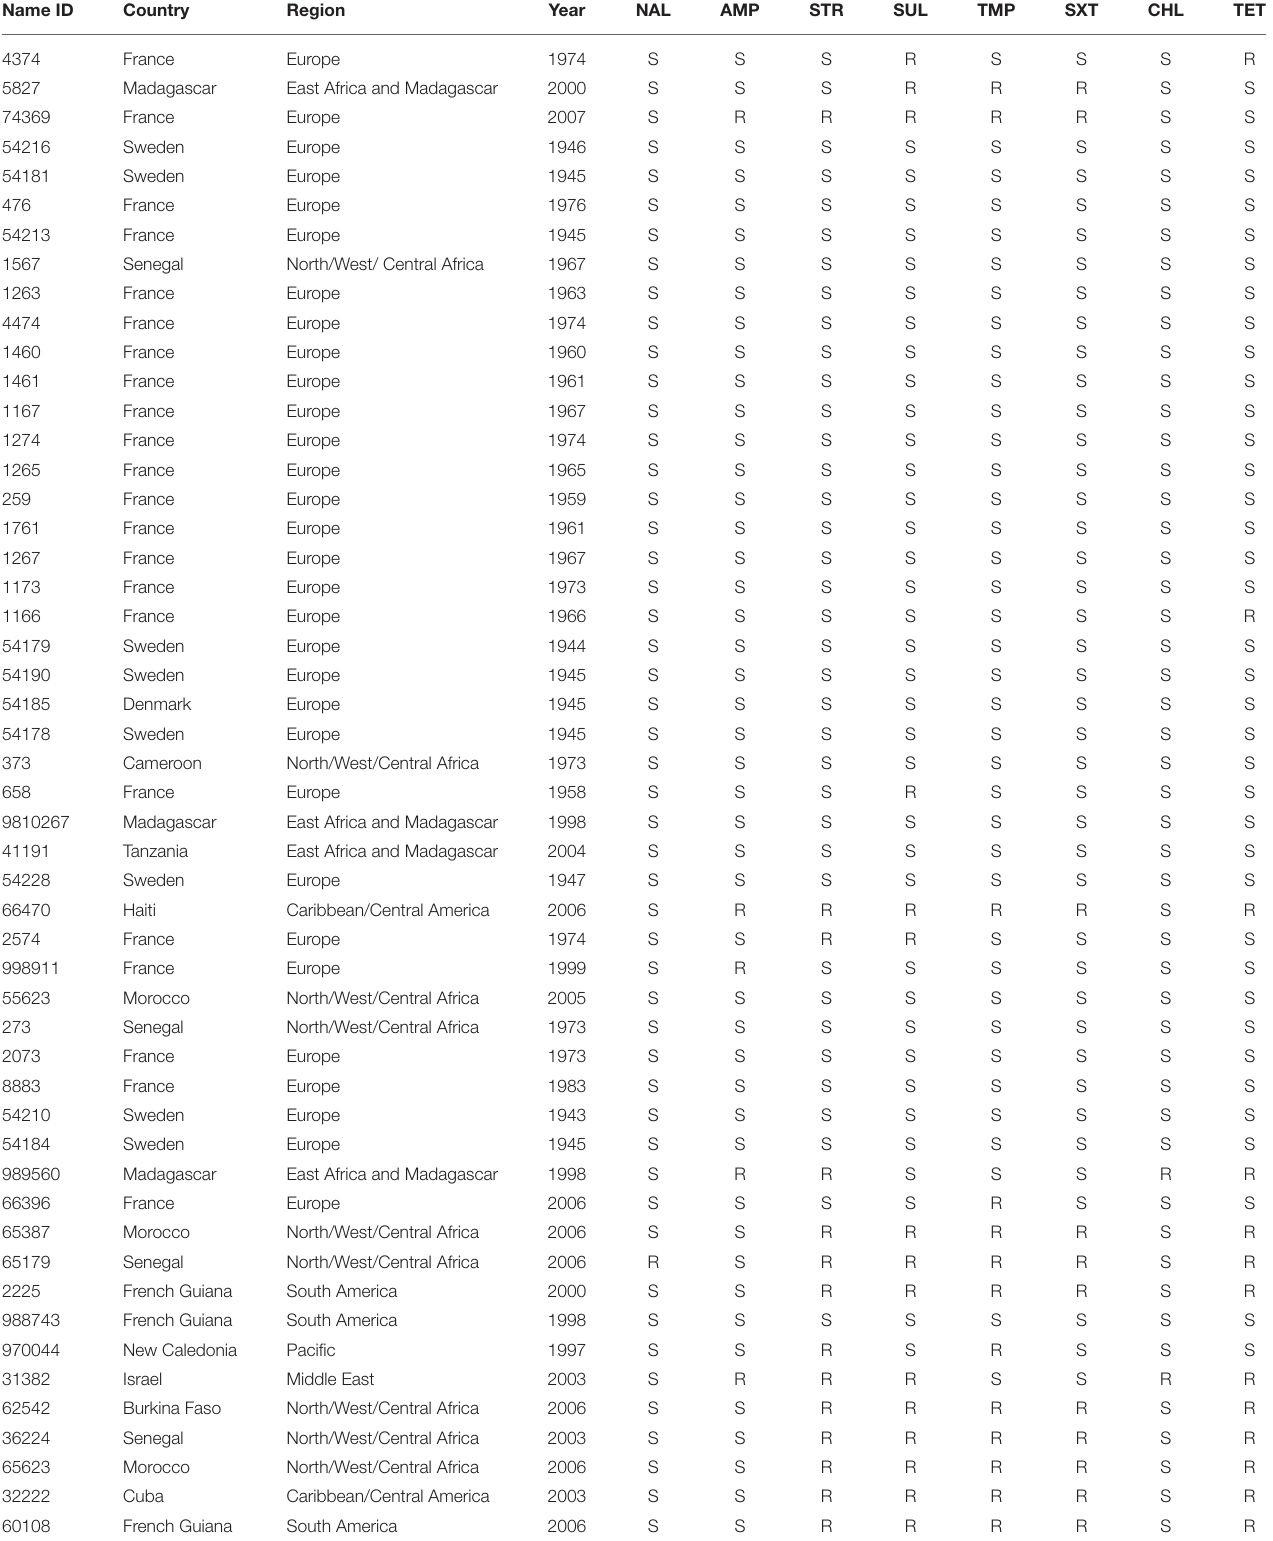
TABLE 1 | Antimicrobial susceptibility characterization of 51 Shigella sonnei strains isolated since 1943 to 2006 from different origins